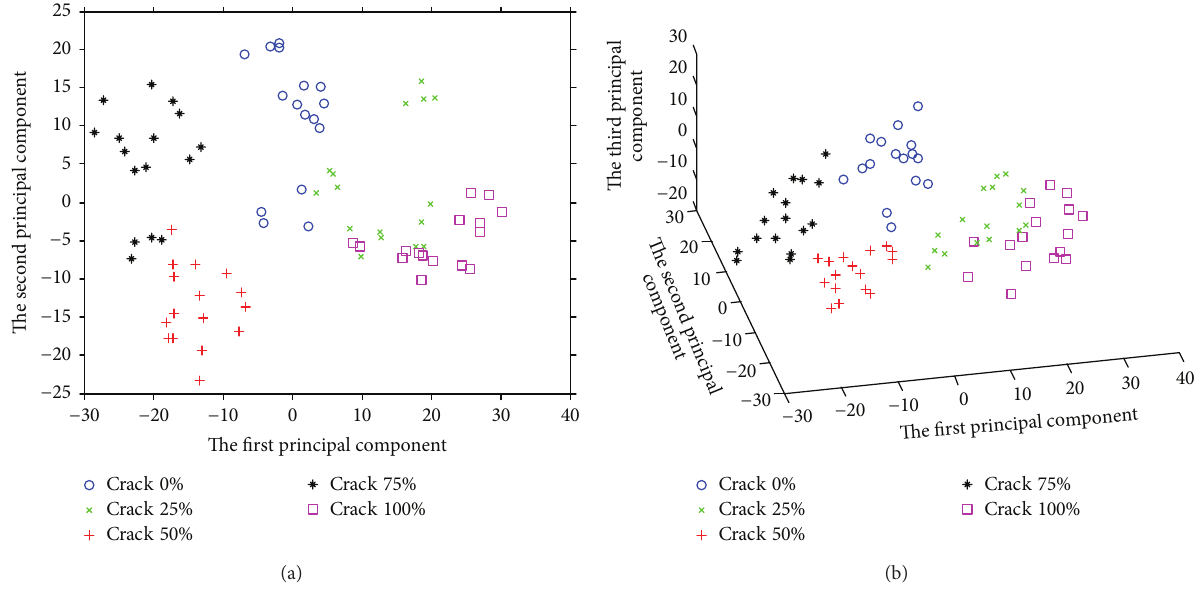
Figure 11: The principal components of the testing data for experiment 3 : (a) the first two principal components; (b) the first three principal